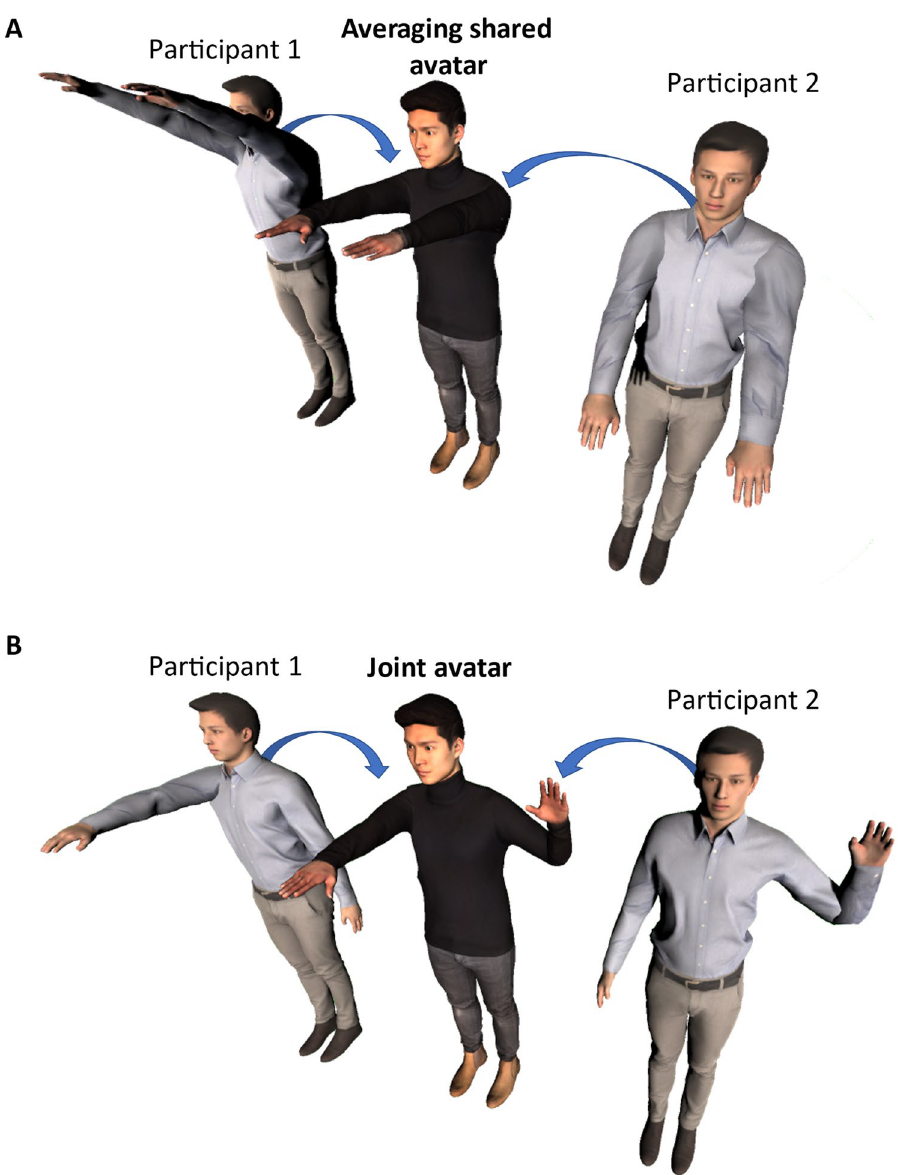
Figure 1. Two types of co-embodiment avatar: ( A ) A shared body avatar is controlled by two individuals, and their movements are averaged and reflected in the shared avatar 7,8 . ( B ) A joint body avatar is an avatar in which different body parts such as left and right half bodies are controlled by two different